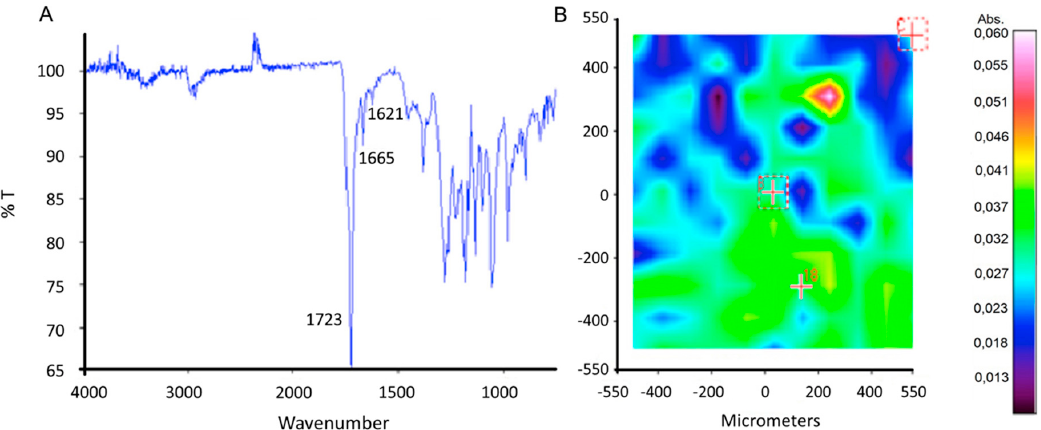
Figure 5. ( A ) Spectrum of PHBHV fiber network loaded with dexamethasone (Dexa); ( B ) correlation map of PHBHV fiber mesh loaded with Dexa in relation to the characteristic spectrum of Dexa.